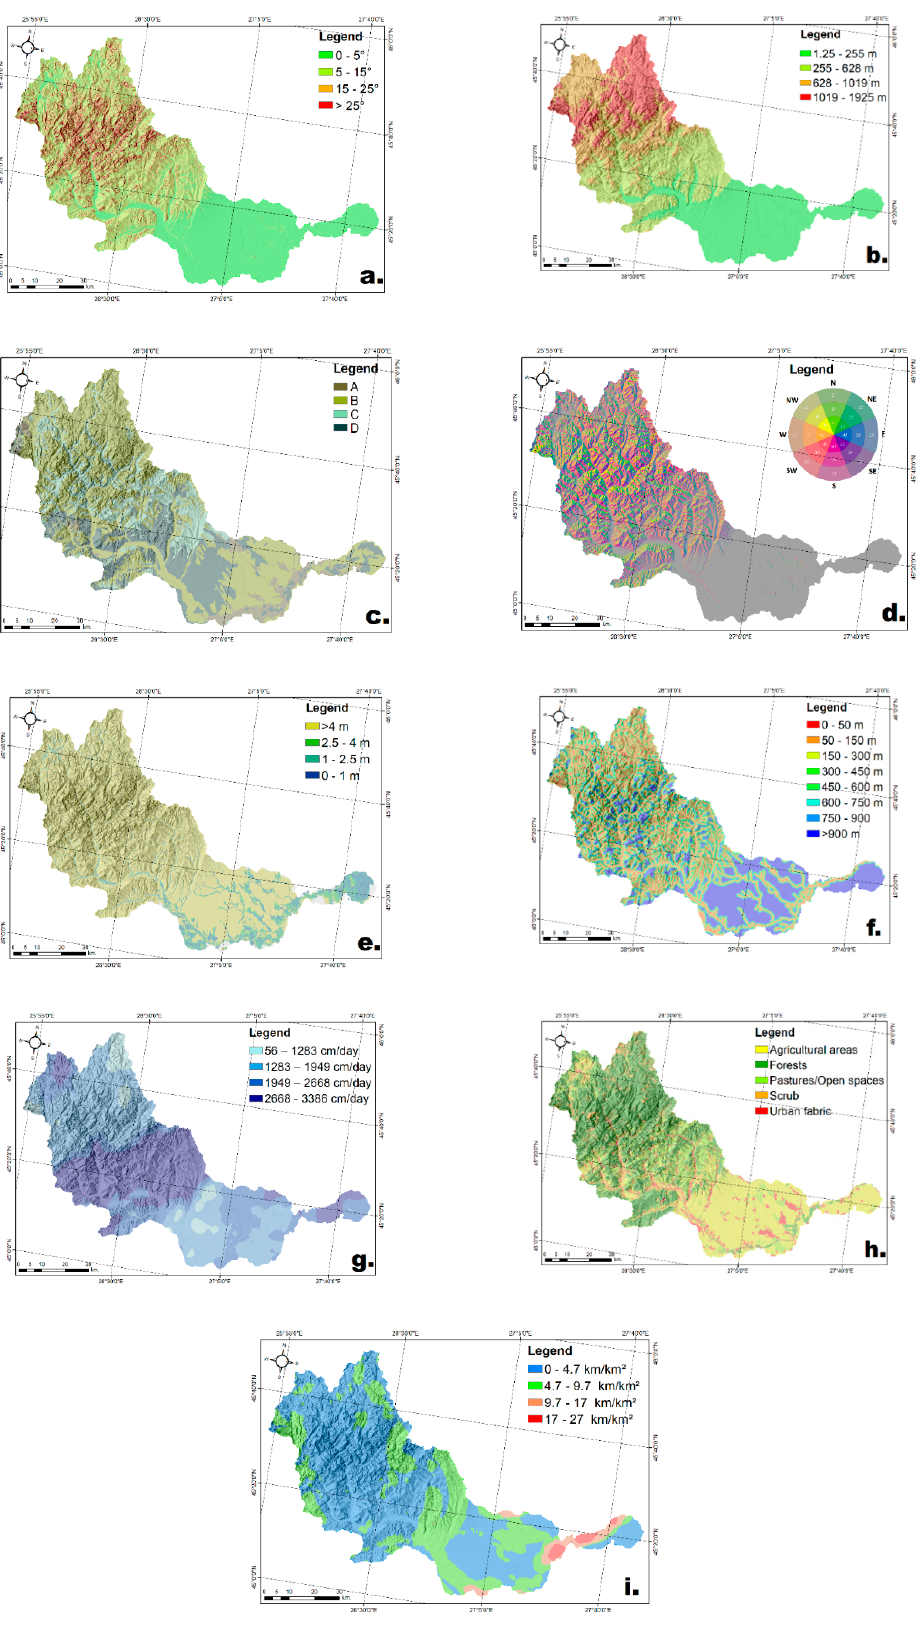
Figure 3. ( a ) Slope, ( b ) elevation, ( c ) hydrological soil group (HSG), ( d ) slope aspect, ( e ) elevation above channel, ( f ) distance from rivers, ( g ) saturated hydraulic conductivity, ( h ) land use, ( i ) drainage